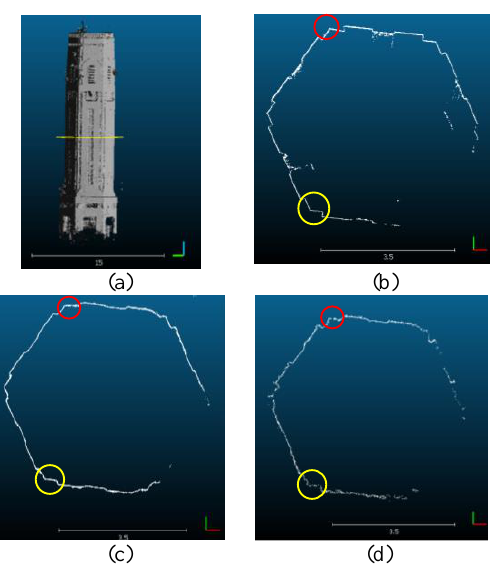
Figure 8: Cross-sections (a) Location of section, (b) TLS, (c) Photoscan, (d)